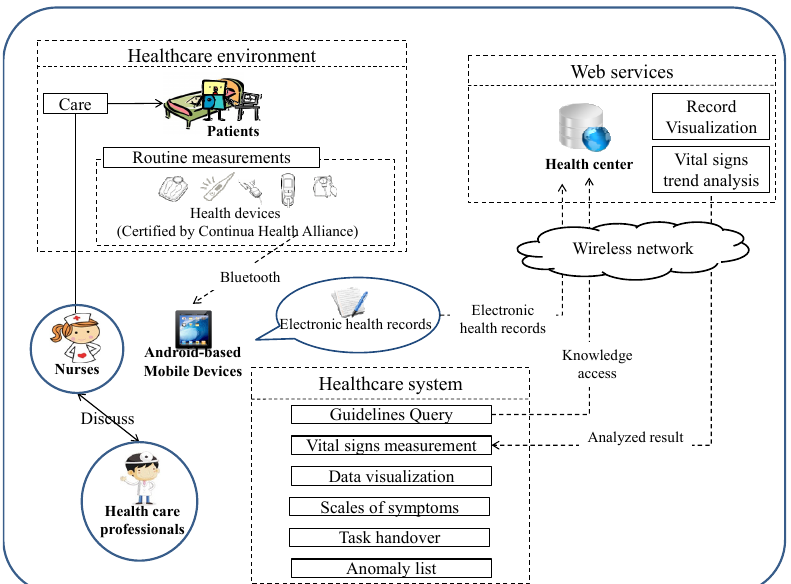
Figure 1. The framework of Cagurs